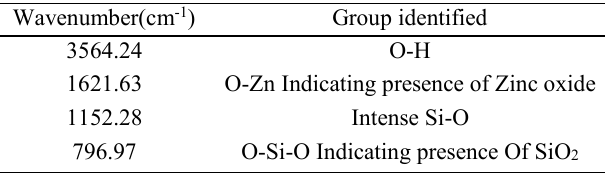
nanocomposite 2